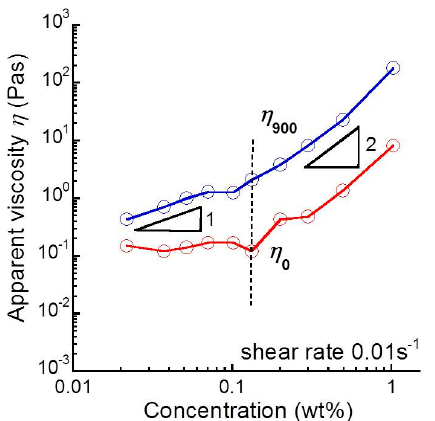
Figure 4. Relationship between sacran concentration and apparent shear viscosity at 0 and 900 s (shear rate: 0.01 s − 1 ).